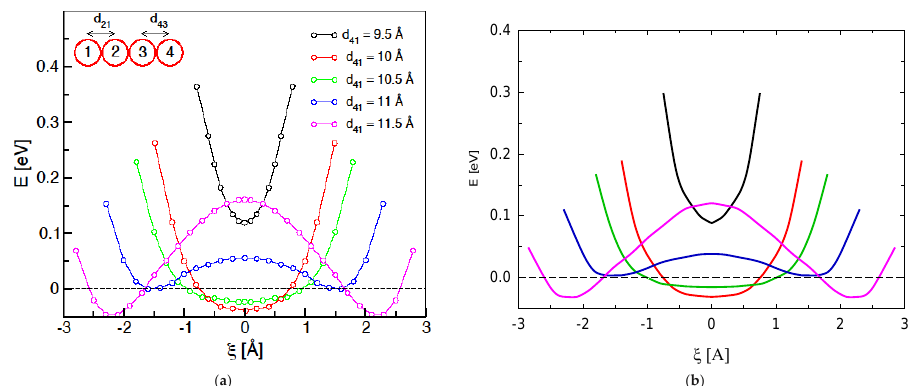
Figure 7. Gas-phase study of the system potential energy as a function of ξ , for various d 41 separations, via ( a ) DFT single-point calculations (from ref. [24]) and, ( b ) the present ReaxFF/charge-reassignment scheme on the right; there is a legend and schematic on the ( a ) panel. A collinear arrangement is adopted for ‘head-on’ approach of 1 and departure of 4. For d 41 is less than, or up to, ~10.5 Å, a single-energy minimum is evident for ξ = 0 (i.e., d 43 = d 21 ), associated with the formation of a symmetric I 42− . Once d 41 exceeds ~10.5 Å, two minima develop, for I − ···· I 3 − and I 3 − ···· I − (the approach of I1 and departure of I4, respectively). Note: the ( a ) graph from ref. [24] is reproduced with the kind permission of the American Chemical Society.